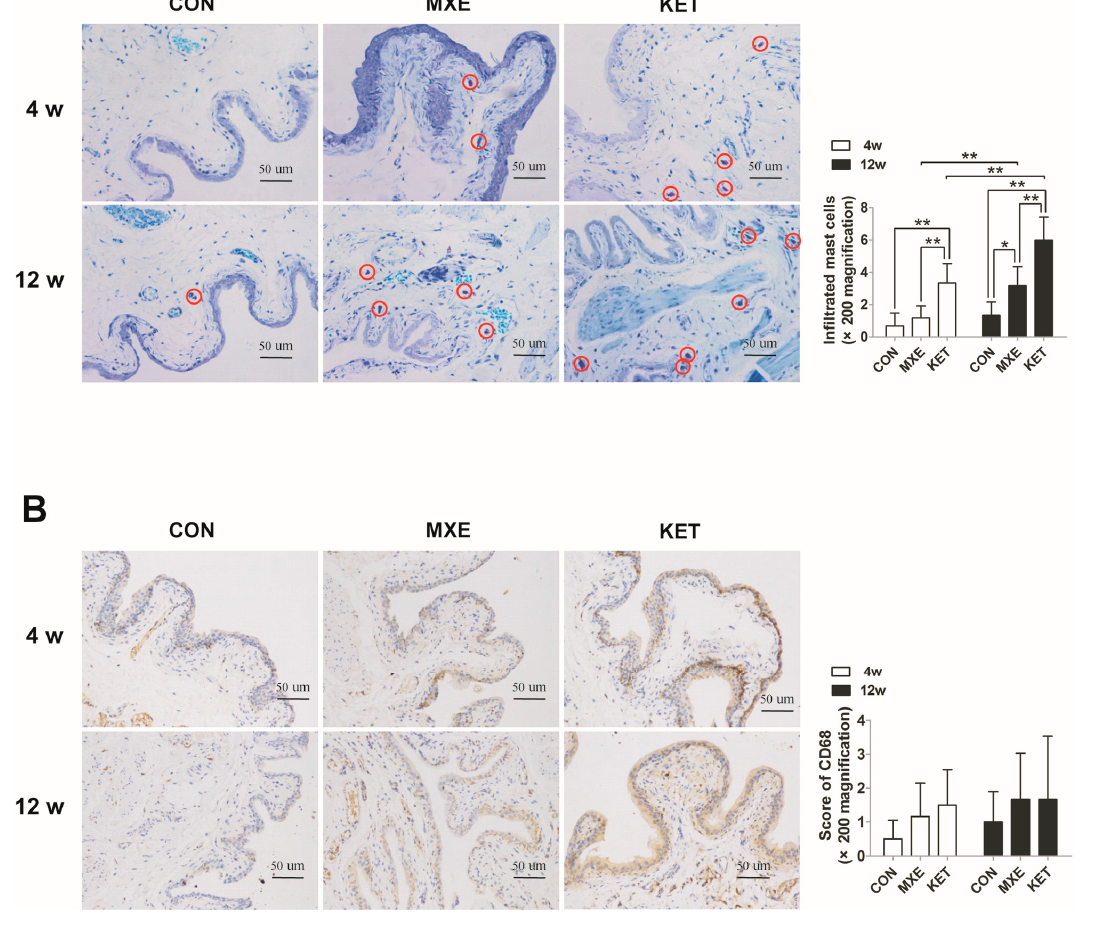
Figure 5. Mast cell and macrophage infiltration in rat bladder tissue after MXE and KET treatment. Representative graphs of toluidine blue-stained mast cells ( A ); and CD68 positive macrophages ( B ) in the three groups ( n = 6 in each group). Magnification: ×200; Scale bar: 50 μ m. Mast cell and macrophage infiltration was greater and tended to increase with drug exposure time in the MXE and KET groups (red circles indicate mast cells). Data were analyzed with two-way. * p < 0.05, ** p < 0.01.